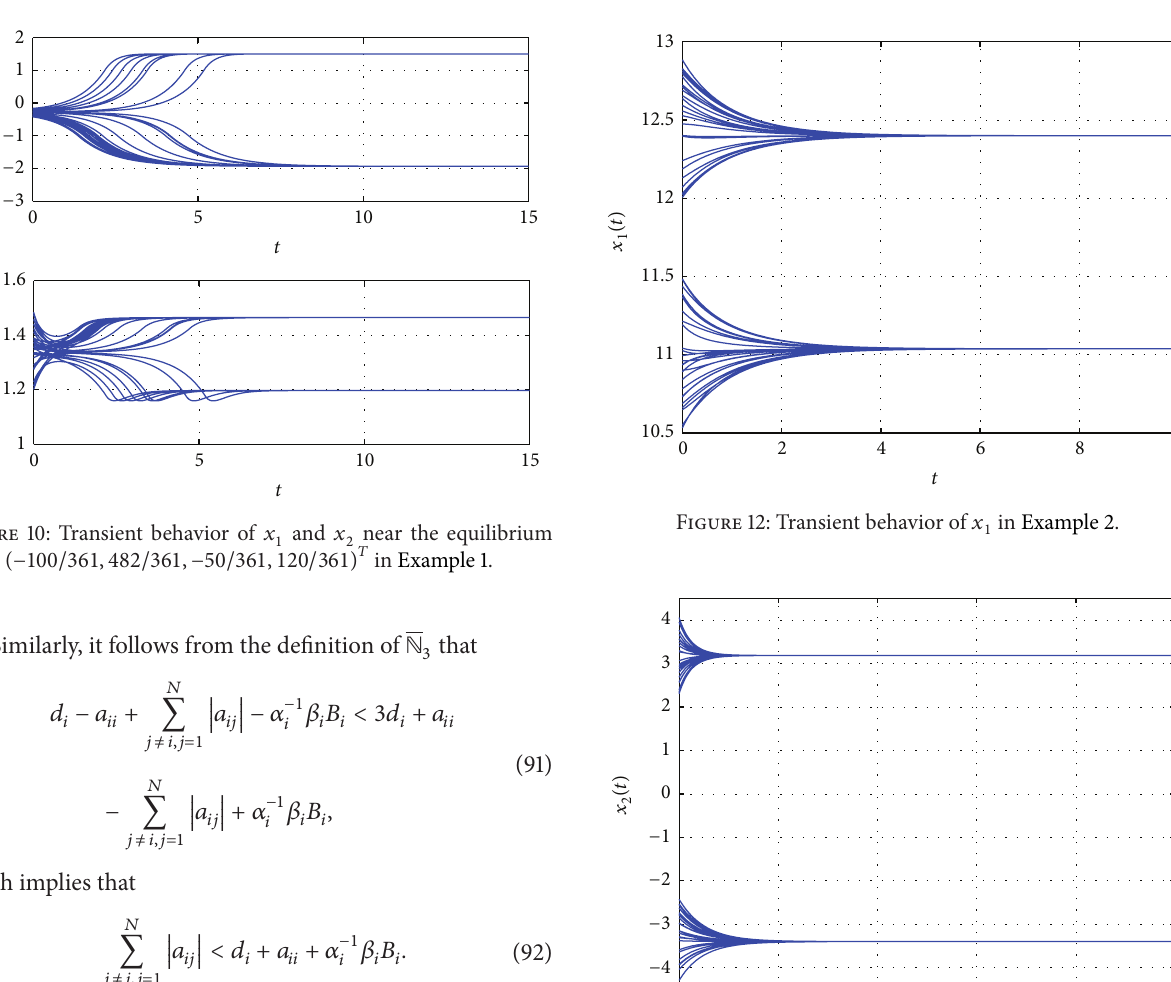
Figure9:Transientbehaviorof 𝑥 1 and 𝑥 2 neartheequilibriumpoint (0,0,0,0) 𝑇 in Example 1.